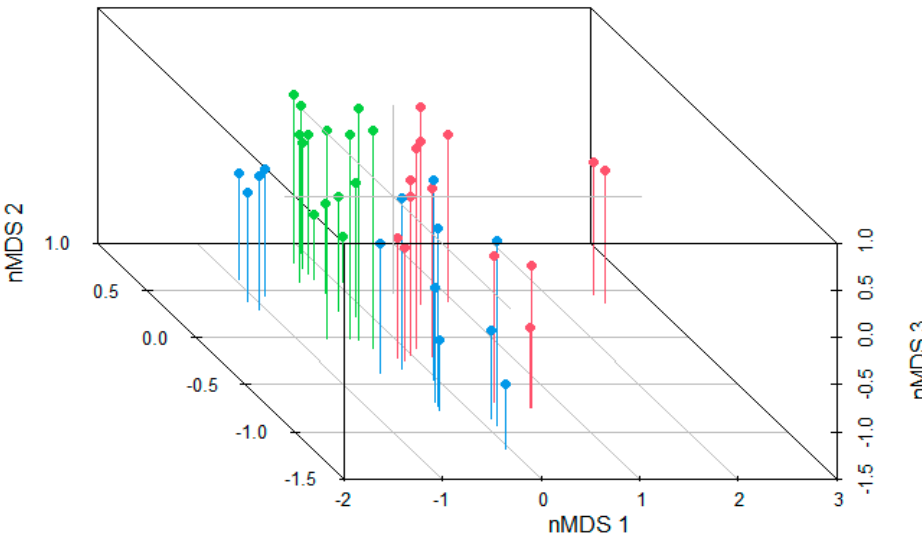
Figure 2. Clustering of tadpoles from natural (green), agricultural (red), and urban (blue) ponds along 3 non-metric multidimensional scaling (nMDS) axes representing the composition of the gut bacterial communities. The two tadpoles in red on the far right stand out because they do not have Bacteroidota, which was the most abundant phylum in the rest of the